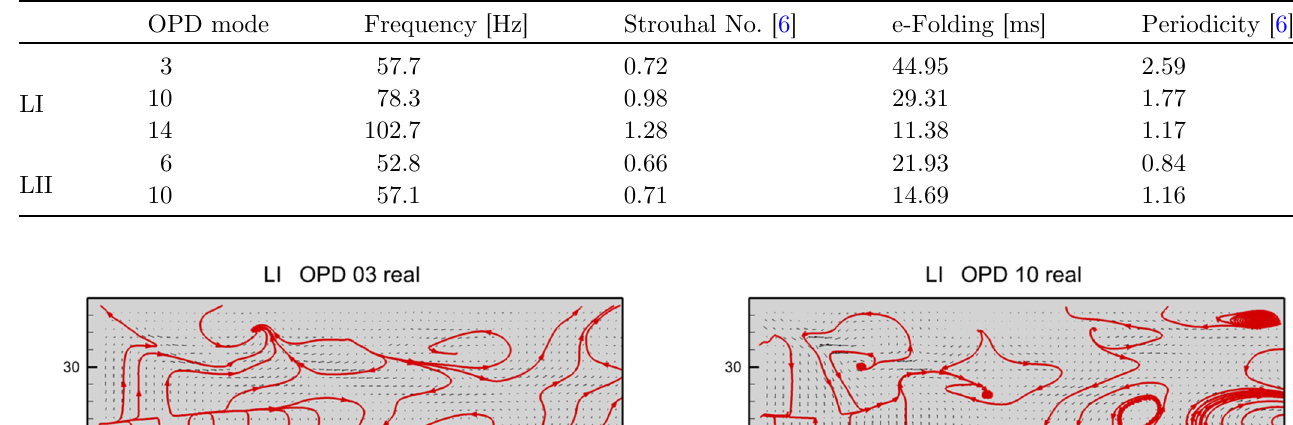
Table 3. Selected OPD modes, branch L.